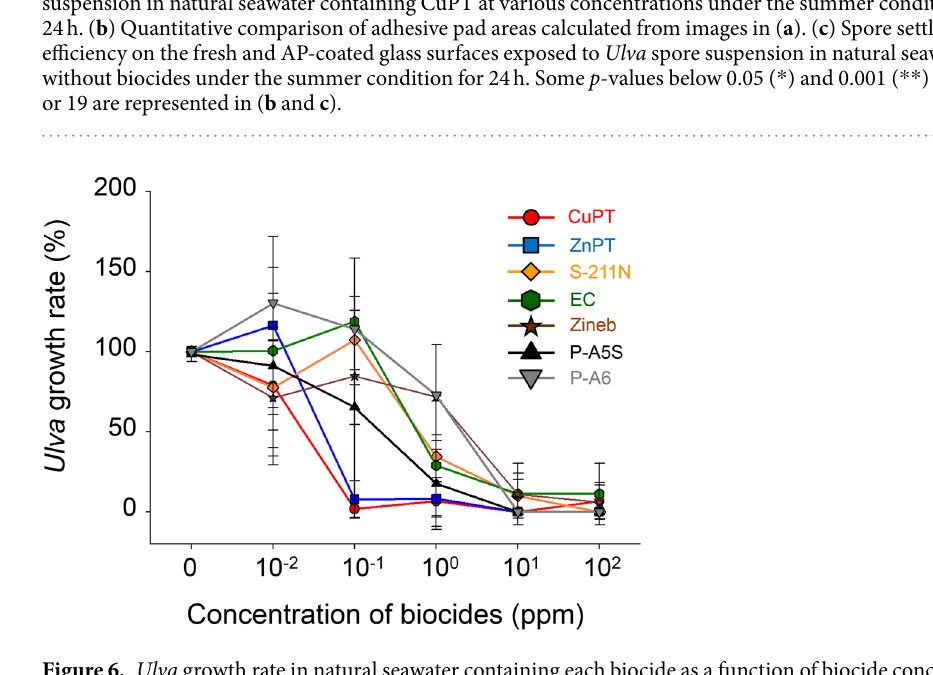
Figure 6. Ulva growth rate in natural seawater containing each biocide as a function of biocide concentration. The Ulva was incubated under the winter condition for one week. The error bars represent the standard deviations with n =